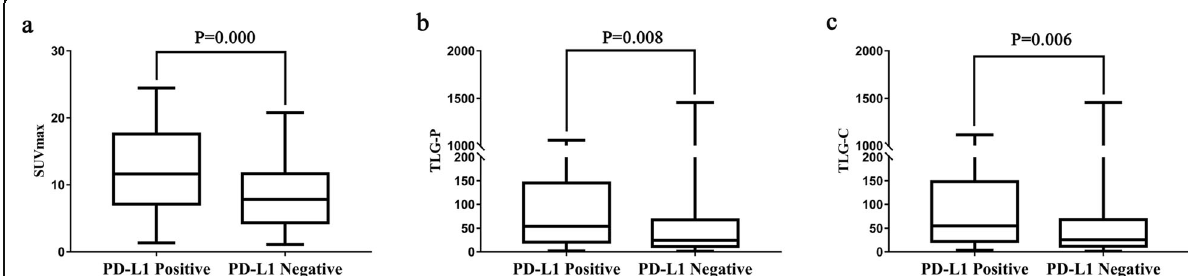
Fig. 1 The correlation between PD-L1 expression and SUVmax ( a ), TLG-P ( b ), and TLG-C ( c ) in overall NSCLC